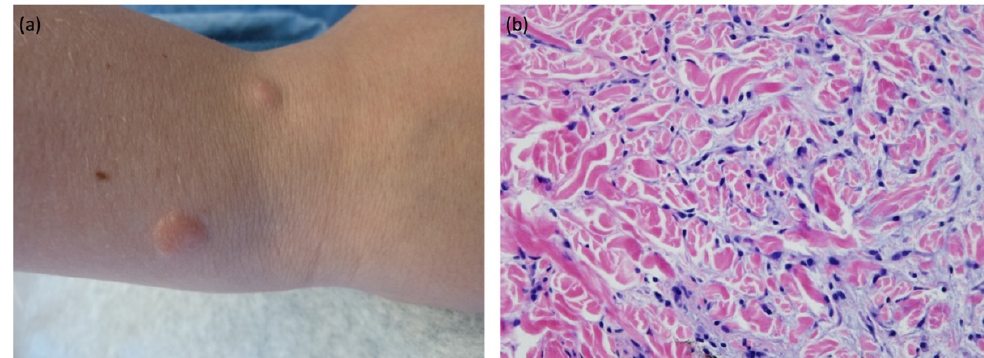
Figure 1. Right distal forearm erythematous, firm nodules ( a ) with H&E, original magnification × 40 ( b ) showing dermal mucin deposition separating the collagen bundles with increased number of fibroblasts as well as histiocytes.